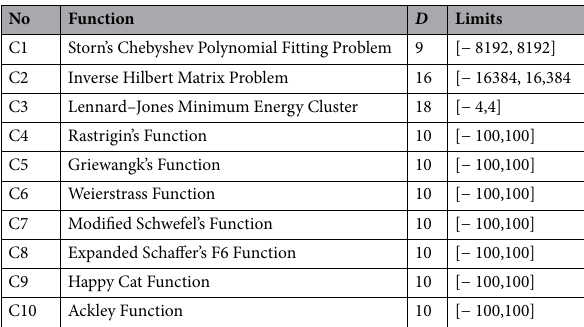
Table 18. Summary of the CEC 2019 test